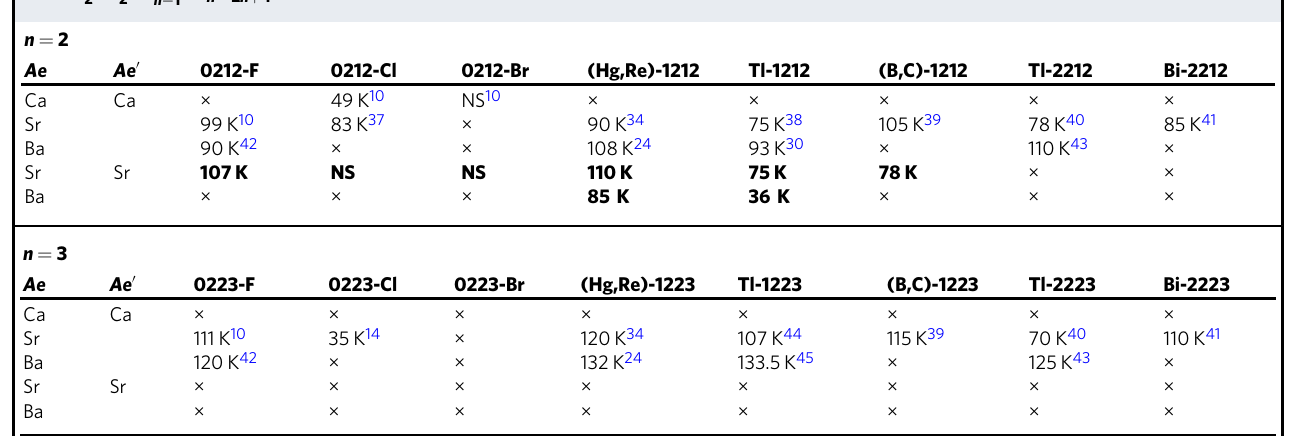
X MAe Ae 0 n (cid:2) 1 Cu n O 2 n + 2 , 2 , 2